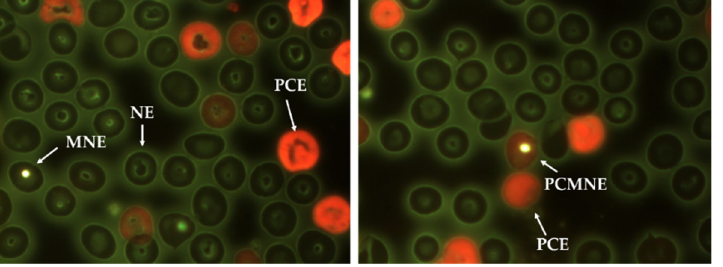
Figure 2. Representative images obtained for each biomarker. White arrows indicate normal eryth- rocytes (NEs), micronucleated erythrocytes (MNEs), polychromatic erythrocytes (PCEs), and micronucleated polychromatic erythrocytes (MNPCEs). Acridine orange staining, microscope Carl Zeiss ® , 100× objective (Zeiss, Darmstadt, Germany).